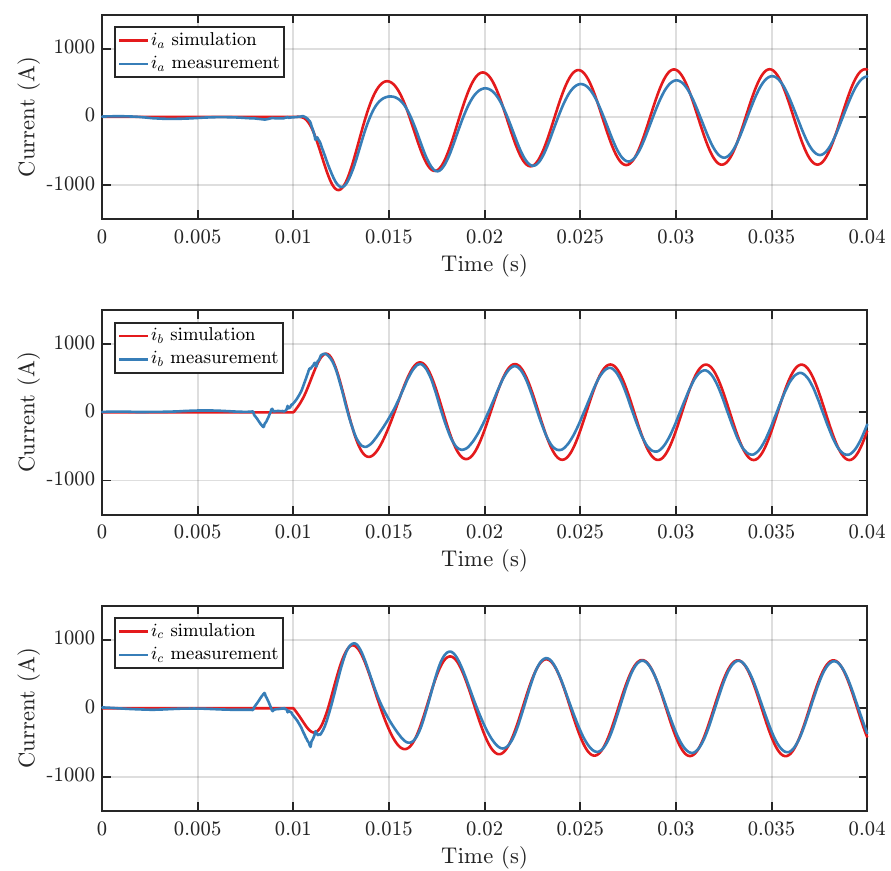
Figure 11. Three-phase short circuit at 3000min − 1 : a direct comparison of simulated and measured phase currents ( top ) i a , ( middle ) i b , and ( bottom ) i c